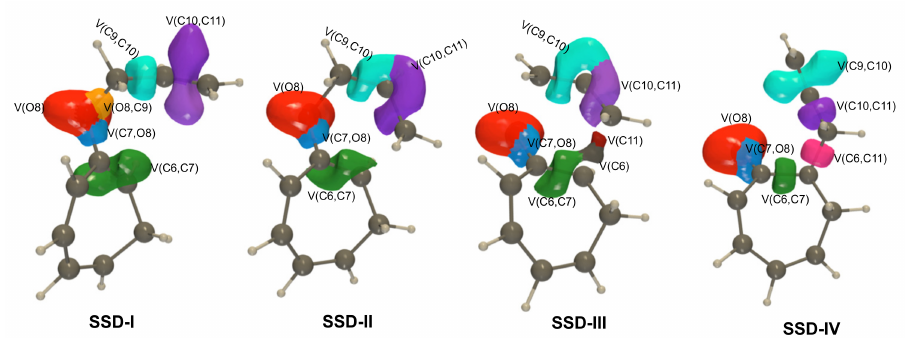
Figure 2. ELF basin isosurfaces ( η = 0.7) of each of the SSDs found along the IRC associated with TS1 . Color labeling of the basins is adopted according to Figure